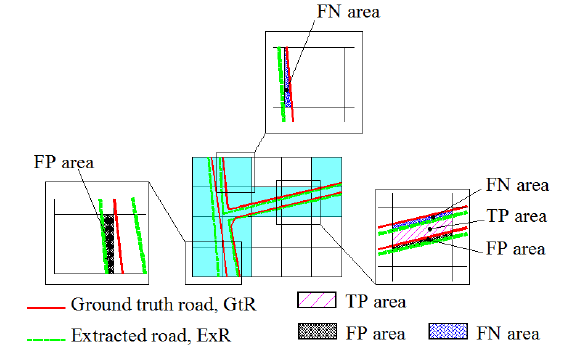
Figure 7. Illustration of computing TP , FP and FN areas The positional accuracy was determined through differences in location and orientation of the road edges between the ground truth and extracted roads. A distance and angle between the road edges from the ground truth and the extracted results were proposed to measure those differences. A pair of road edges (L GtRi from GtR and L ExRi from ExR ) was initially extracted. For that, if C GtRi (x,y) = 1, a pavement edge segment from GtR overlapping C GtRi (x , y) was computed, which was called L GtRi . Then, if the angle between the L GtRi and a horizontal direction (n x = [1,0]) was less than or equal to 45 degrees, a pavement edge segment of the ExR on the same vertical grid to the C GtRi (x , y) closest to the L GtRi was considered the L ExRi . Otherwise, the pavement edge segment of the ExR on the horizontal grid to the C GtRi (x , y) closest to the L GtRi was designated the L ExRi (Figure 8). From the pair of the road edge segments, the distance and orientation errors (L GtRi and L ExRi , respectively) were computed according to Eq.s 11 and 12, where the distance between L GtRi and L ExRi was the distance between the middle of the L ExRi and the L GtRi.